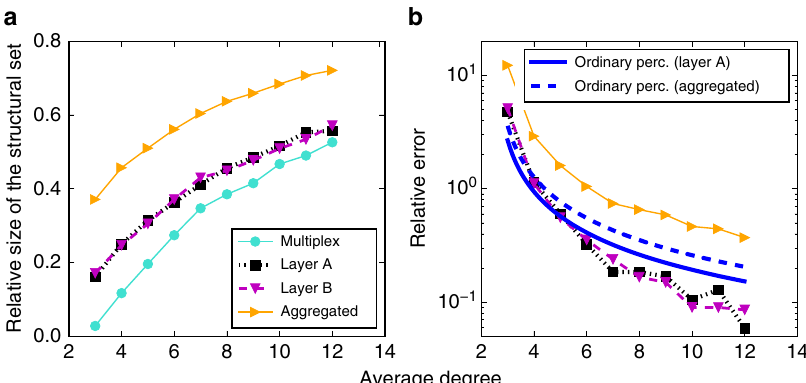
Fig. 2 Optimal percolation problem on synthetic multiplex networks. a We consider multiplex networks with N = 1,000 and layers generated independently according to the Erdös − Rényi model with average degree 〈 k 〉 . We estimate the relative size of the set of SNs on the multiplex as a function of 〈 k 〉 (turquoise circles), and compare it with the same quantity but estimated on the individual layers (black squares and purple triangles) or the aggregated (orange triangles). b The relative errors of single-layer estimates of the size of the structural set with respect to the ground-truth value provided by the multiplex estimate. Colors and symbols are the same as those used in a . The blue curves with no markers represent instead the theoretically expected behavior for